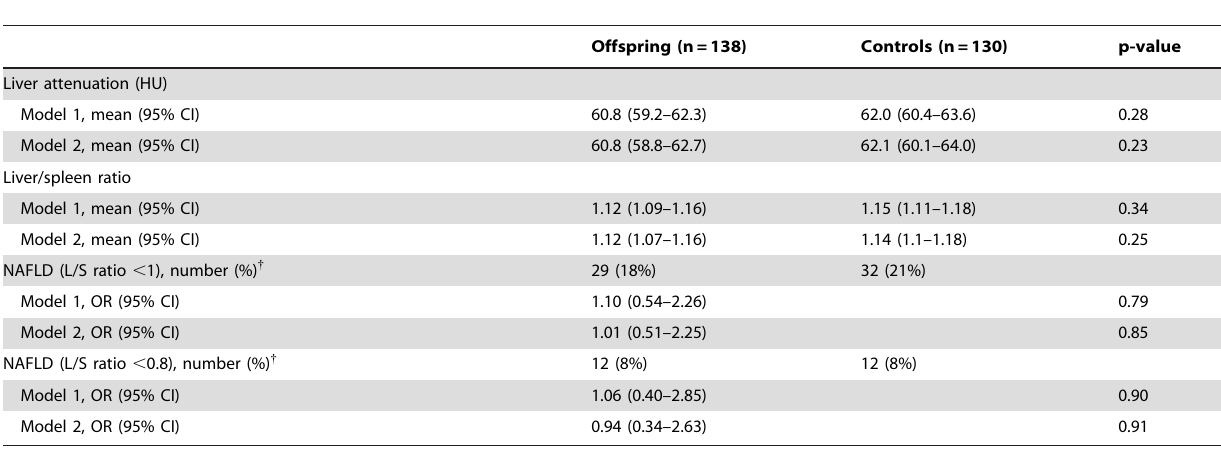
Table 4. Computed tomography markers of liver steatosis in offspring of long-lived siblings and control subjects.